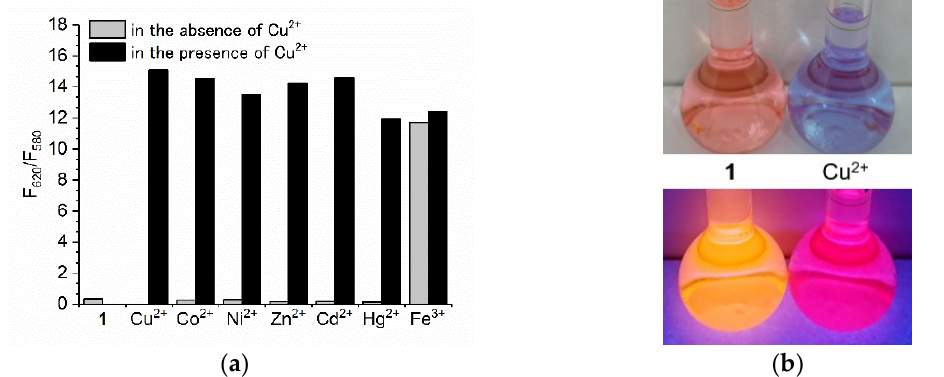
Figure 6. ( a ) Changes in the ratio of fluorescence intensities ( F 620 / F 580 ) of BODIPY 1 (3 µ M) on addition of different metal cations. The gray bars represent the addition of each cation (30 µ M). The black bars represent subsequent addition of Cu 2+ (30 µ M). The excitation wavelength was 550 nm. ( b ) Photos of BODIPY 1 solution (4 µ M) containing tap water (acetonitrile/tap water = 9/1, v/v ) in the absence ( 1 , left flask) and the presence of Cu 2+ (Cu 2+ , right flask). Cu 2+ was spiked with tap water in advance. The concentration of Cu 2+ in tap water was 30 ppm (470 µ M). The fluorescence color was observed under excitation at 365 nm.